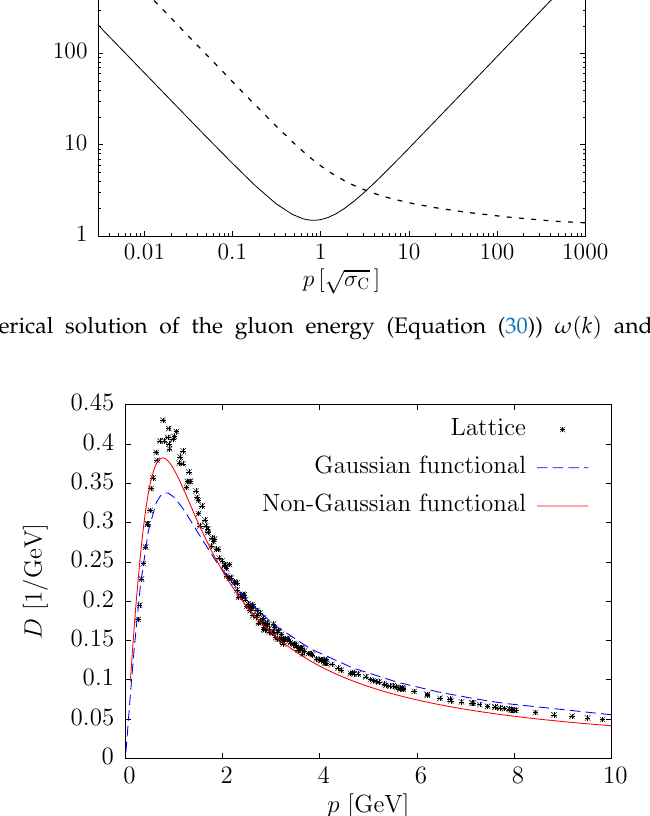
Figure 2. The static gluon propagator in Coulomb gauge calculated on the lattice for SU(2) gauge theory (crosses). The dashed and the full curves show the result of the variational calculation using, respectively, a Gaussian ansatz and a non-Gaussian ansatz for the vacuum wave